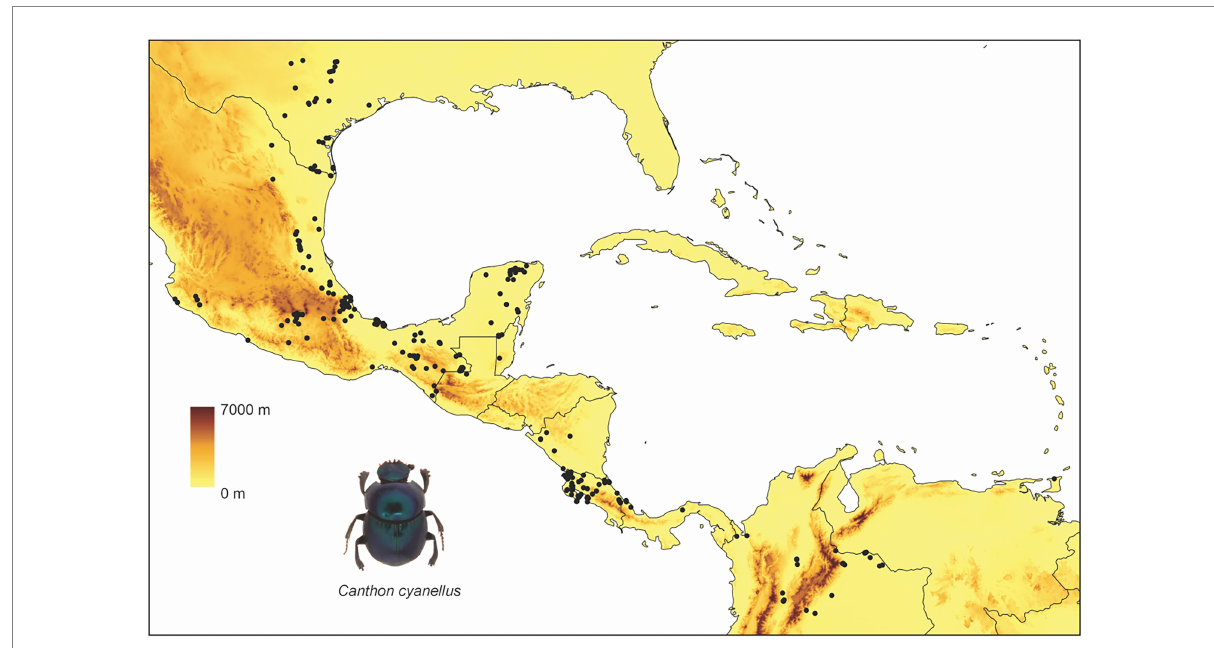
FIGURE 1 Distribution of Canthon cyanellus . This is how GBIF suggests citing records from different datasets: https://www.gbif.org/ occurrence download, Global Biodiversity Information Facility (2020).